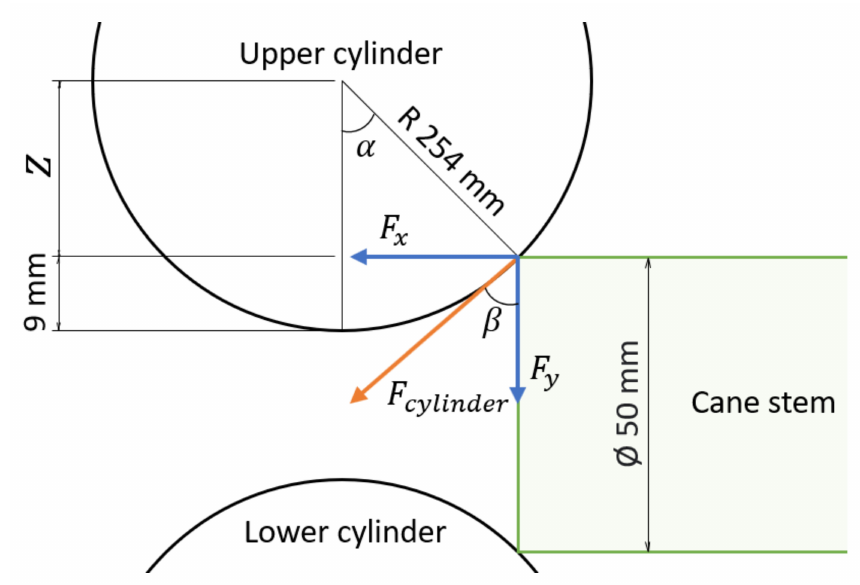
Figure 29. Schema of forces in sugarcane